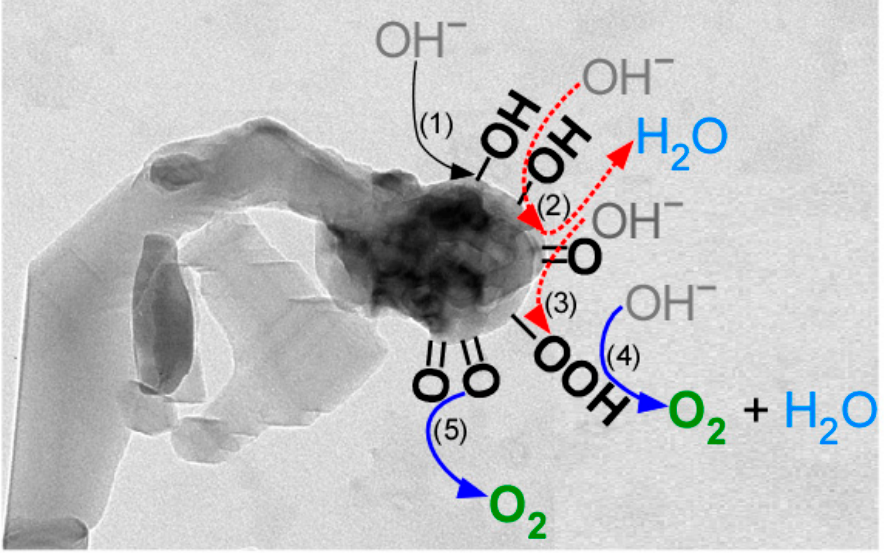
Figure 10. OER mechanism occurring on the Co oxide head in the bean sprout-like Co-TiO 2 /Ti